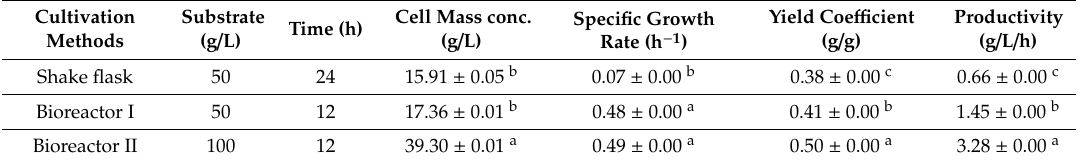
Table 2. Comparison of kinetic parameters of K. marxianus SS106 cell biomass productions in shake flask and in aerobic bioreactors at 40 ◦ C with di ff erent substrate